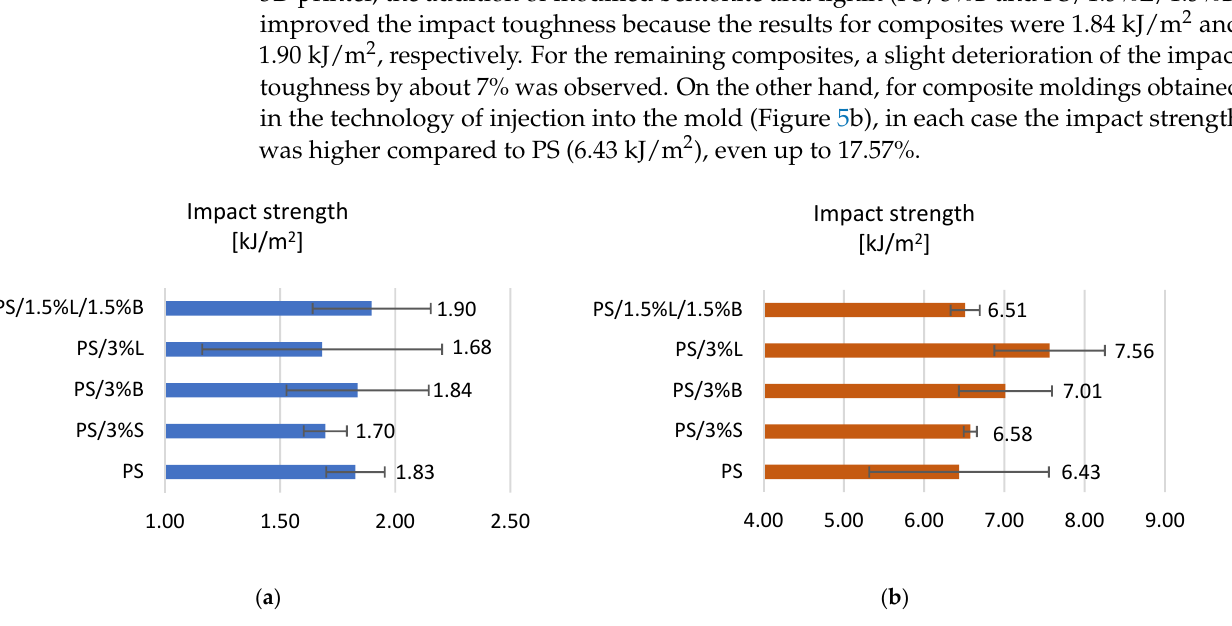
Figure 5. Impact strength test results of ( a ) samples obtained by 3D printing, ( b ) samples obtained by injection molding.